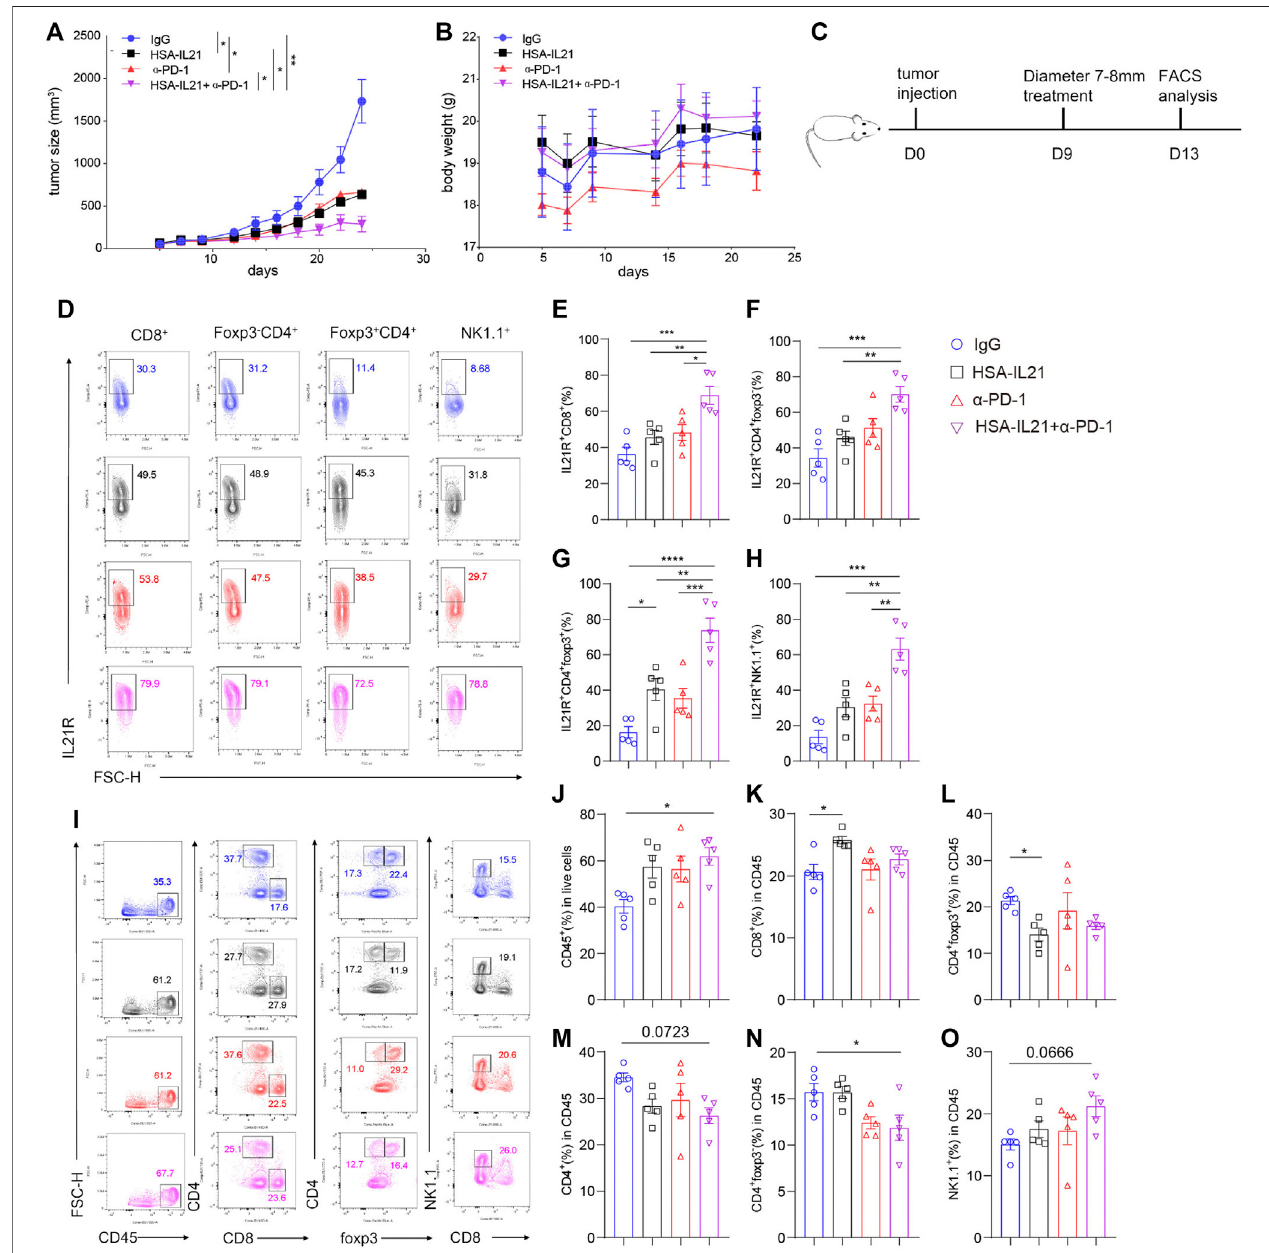
FIGURE 2 | HSA-IL21 and PD-1 blockade combination therapy additively inhibited tumor growth. (A,B) MC38 tumor cells (1 × 10 6 ) were injected intradermally to B6 mice, monitored tumor volume (A) and body weight (B) of tumor-bearing mice treated with IgG, HAS-IL21, α -PD-1, HSA-IL21/ α -PD-1. Data were presented as mean ± SEM, n (cid:2) 4 – 5, *p < 0.05,** p < 0.01,*** p < 0.001,**** p < 0.0001,two-wayANOVAtestwereperformed.(C)Graphicschematicsofthemouseexperiment.MC38 tumor cells (1 × 10 6 ) were injected intradermally to B6 mice, 9 days after tumor inoculation, MC38 tumor-bearing mice were treated with IgG, HSA-IL21, α -PD-1, HSA-IL21/ α -PD-1.96h later, tumor-in fi ltrating lymphocytes were analyzed by fl ow cytometry. (D) Representative fl ow plots of IL21R expression on tumor-in fi ltrating CD8 + ,Foxp3 - CD4 + ,Foxp3 + CD4 + TandNKcells. (E – H) QuantitativeanalysisofIL21Rexpressiondepictedin (D) .Datawerepresentedasmean ± SEM, n (cid:2) 5, *p < 0.05, ** p < 0.01,*** p < 0.001,**** p < 0.0001,one-wayANOVAtestwereperformed. (I) Representative fl owplotsshowingthepercentageofmainimmunepopulations. (J – O) Quantitativepercentageoftumor in fi ltrating CD45 + lymphocytes,percentagesofCD8 + T,CD4 + Tcells,Foxp3 + CD4 + ,Foxp3 - CD4 + Tand NKcells.Datawerepresented as mean ± SEM, n (cid:2) 5, *p < 0.05, ** p < 0.01, *** p < 0.001, **** p < 0.0001, one-way ANOVA test was performed.